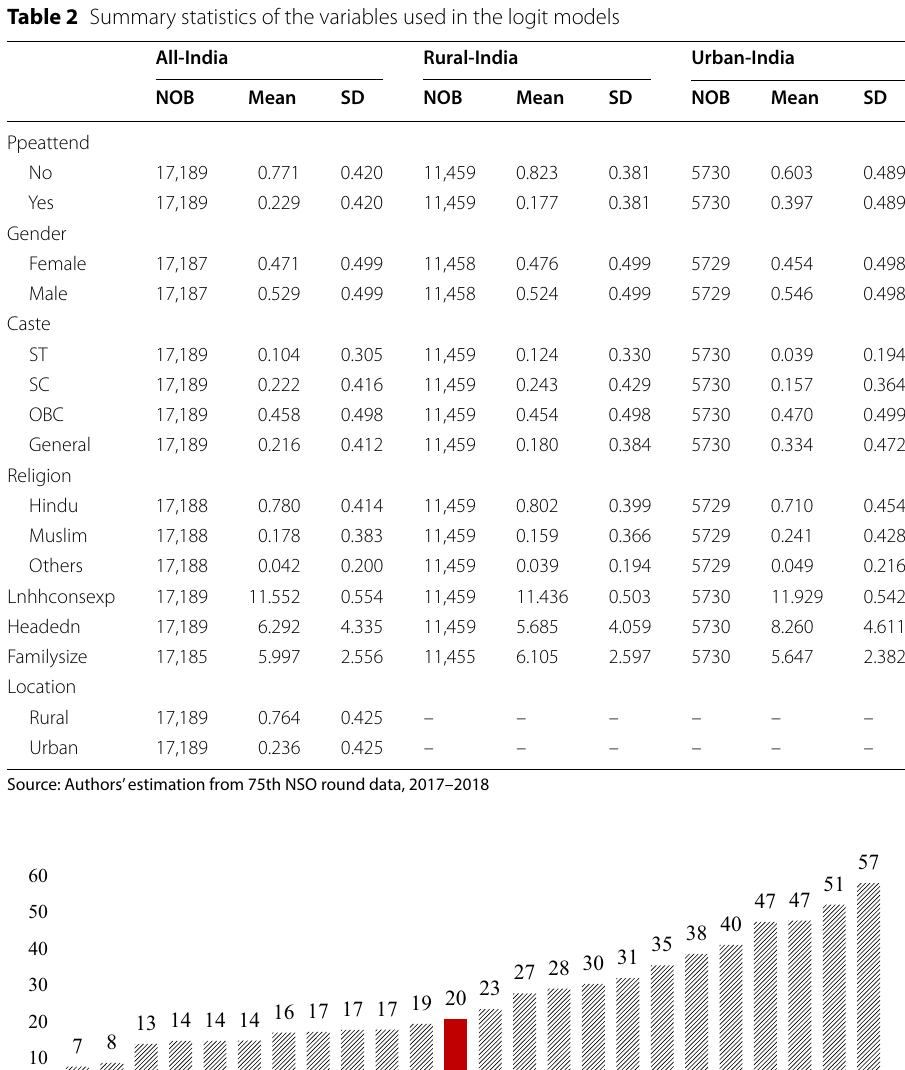
Table 2 Summary statistics of the variables used in the logit models